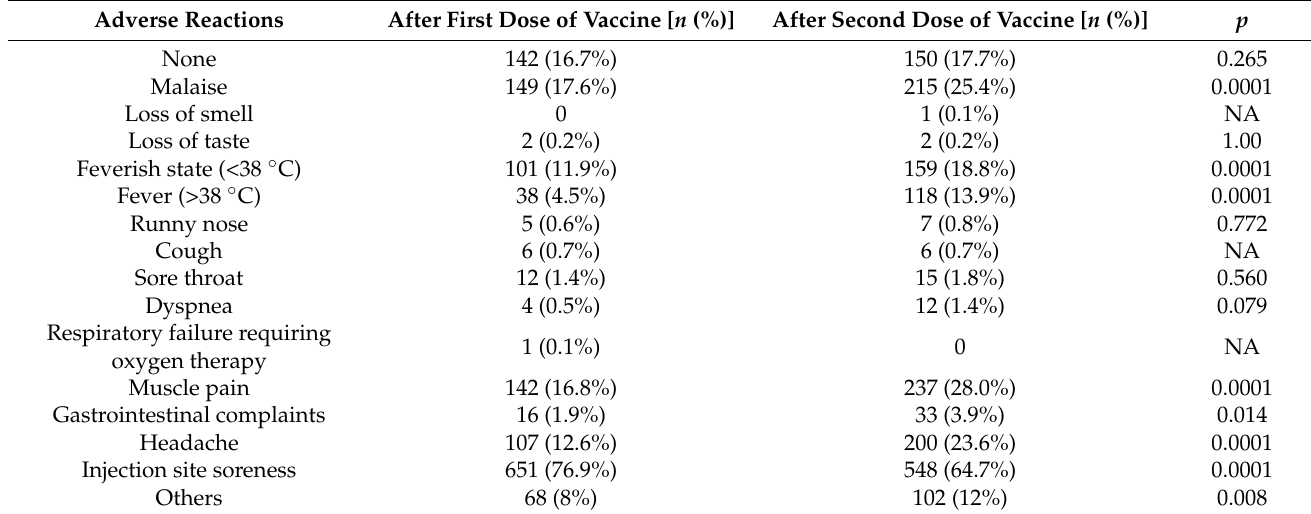
Table 2. Comparison of the frequency of adverse reactions after the first and the second dose of BNT162b2.